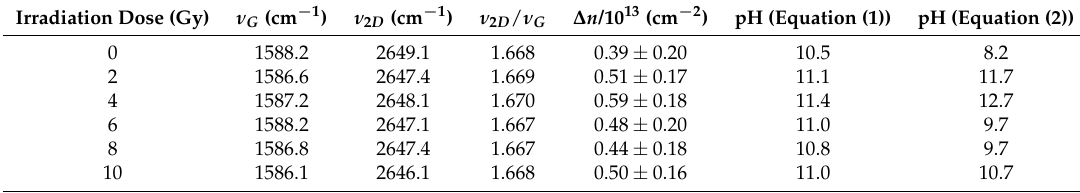
Figure 5. Left axis: Change of carrier doping of graphene in contact with DMEM-A irradiated by X-rays at doses of 0, 2, 4, 6 and 8 Gy (black symbols) and with DMEM-B irradiated at 0, 2 and 4 Gy (red symbols), evaluated by micro-Raman spectroscopy. The data are compared with the intrinsic doping level of bare graphene (pH = 7.0) and DMEM-B ∗ (samples without contact with cells). Right axis: Evaluated pH values of the investigated culture media. Table 1. Experimental results for DMEM-A exposed to different doses of X-ray radiation. Irradiation Dose